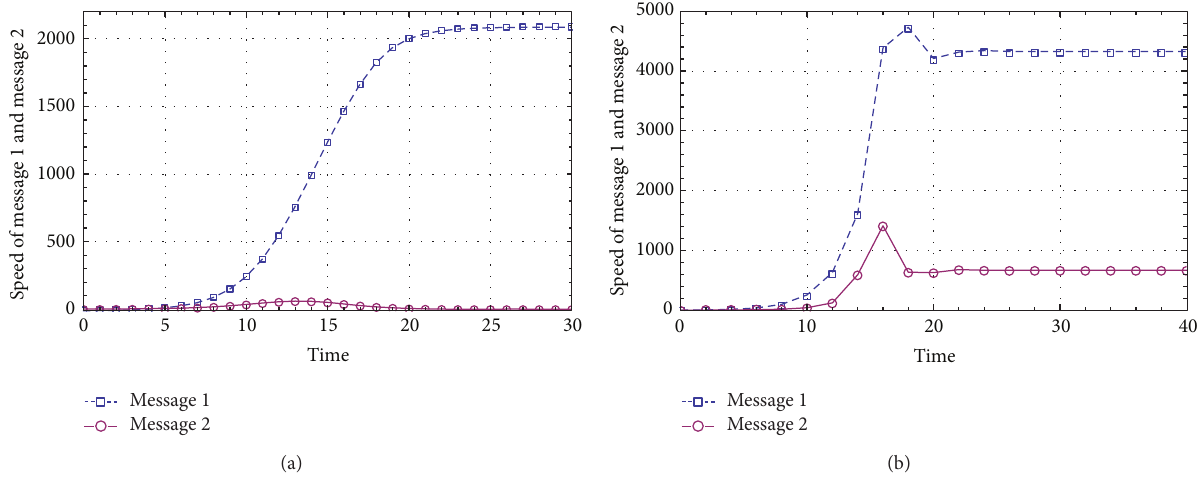
Figure 10: Positive or negative effects for different critical speed with V 1 (0) = 2 , V 2 (0) = 1 , 𝑉 1 = 3000 , 𝜎 10(𝑎) 12 = 3 , 𝜇 1 = 0.7 , 𝜆 1 = 0.2 , 𝑉 2 = 1800 , 𝜎 10(𝑎) = 2 , 𝜇 = 0.5 , and 𝜆 = 0.15 . (a) V V 2 2 1 and 2 as a function of 21 𝛽 = 1200